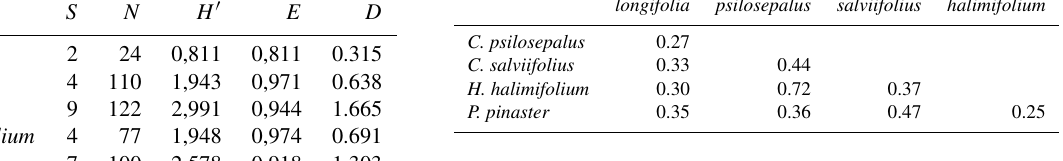
Table 3. Ecological indexes for each plant species considering the Table 4. Similarity matrix between the ECM community associ- identified ECM symbionts. S is the total number of species, N is ated with each plant species studied and calculated using the Bray– the total number of ECM tips, H (cid:48) is the Shannon–Wienner index, Curtis index of E is the Pielou index and D is the Margalef index. S N H (cid:48) E D